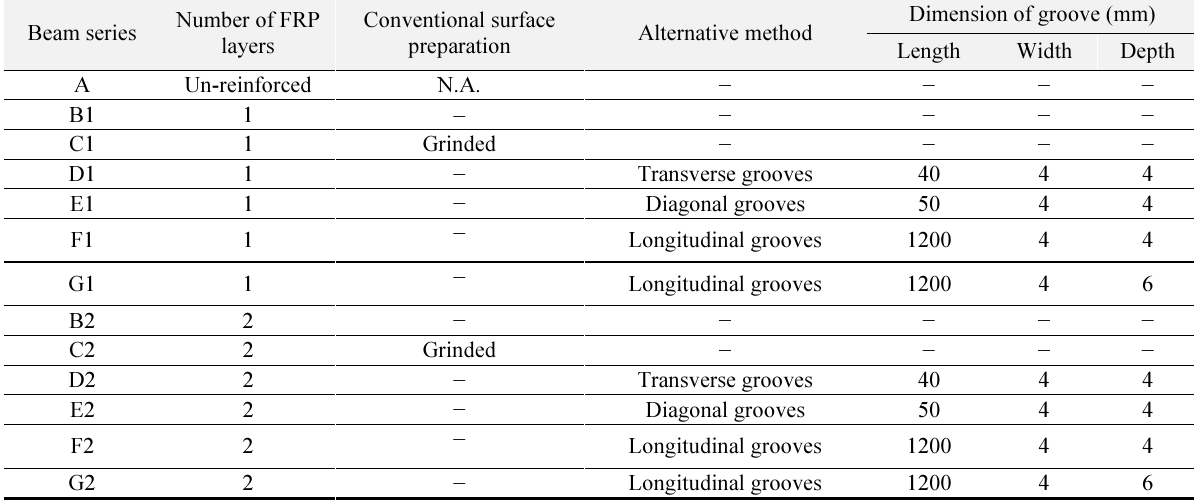
Table 5. Specifications of test